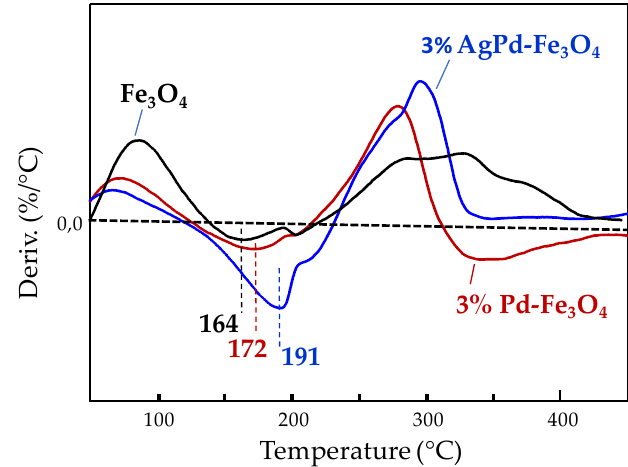
Figure 9. The first derivative of the thermogravimetry (TG) curves collected under synthetic air flow for the monometallic 3% Pd-Fe 3 O 4 and the bimetallic 3% AgPd-Fe 3 O 4 catalysts, as well as for the pristine metal-free Fe 3 O 4 -based substrate.